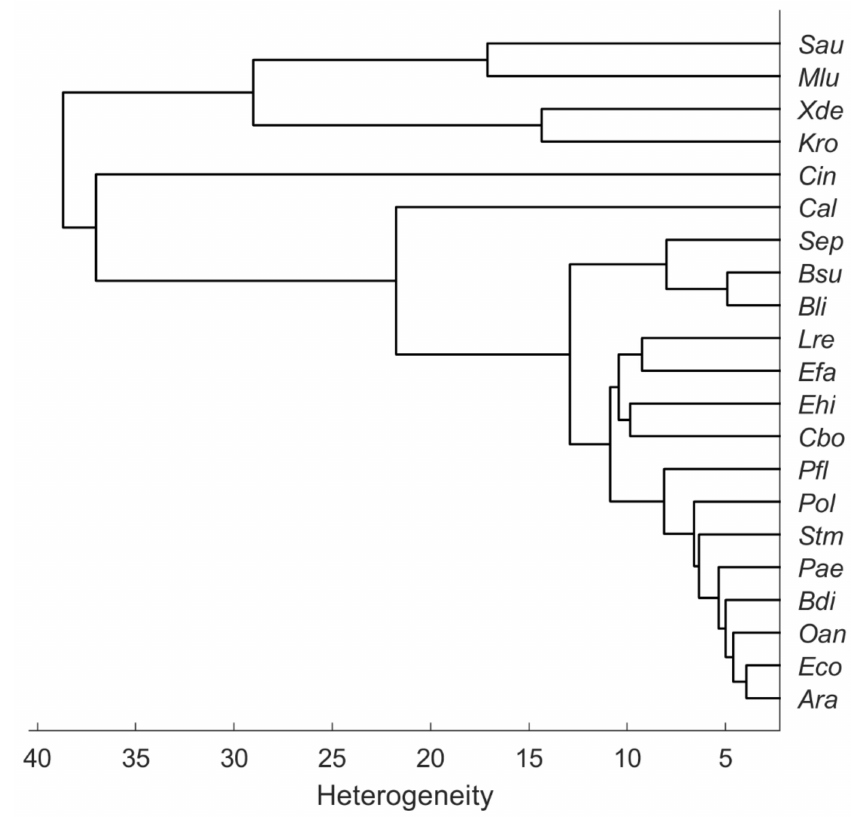
Figure 4. Hierarchical cluster analysis of the mean spectra recorded from microorganisms on the silver mirror slide (average linkage clustering, Euclidean